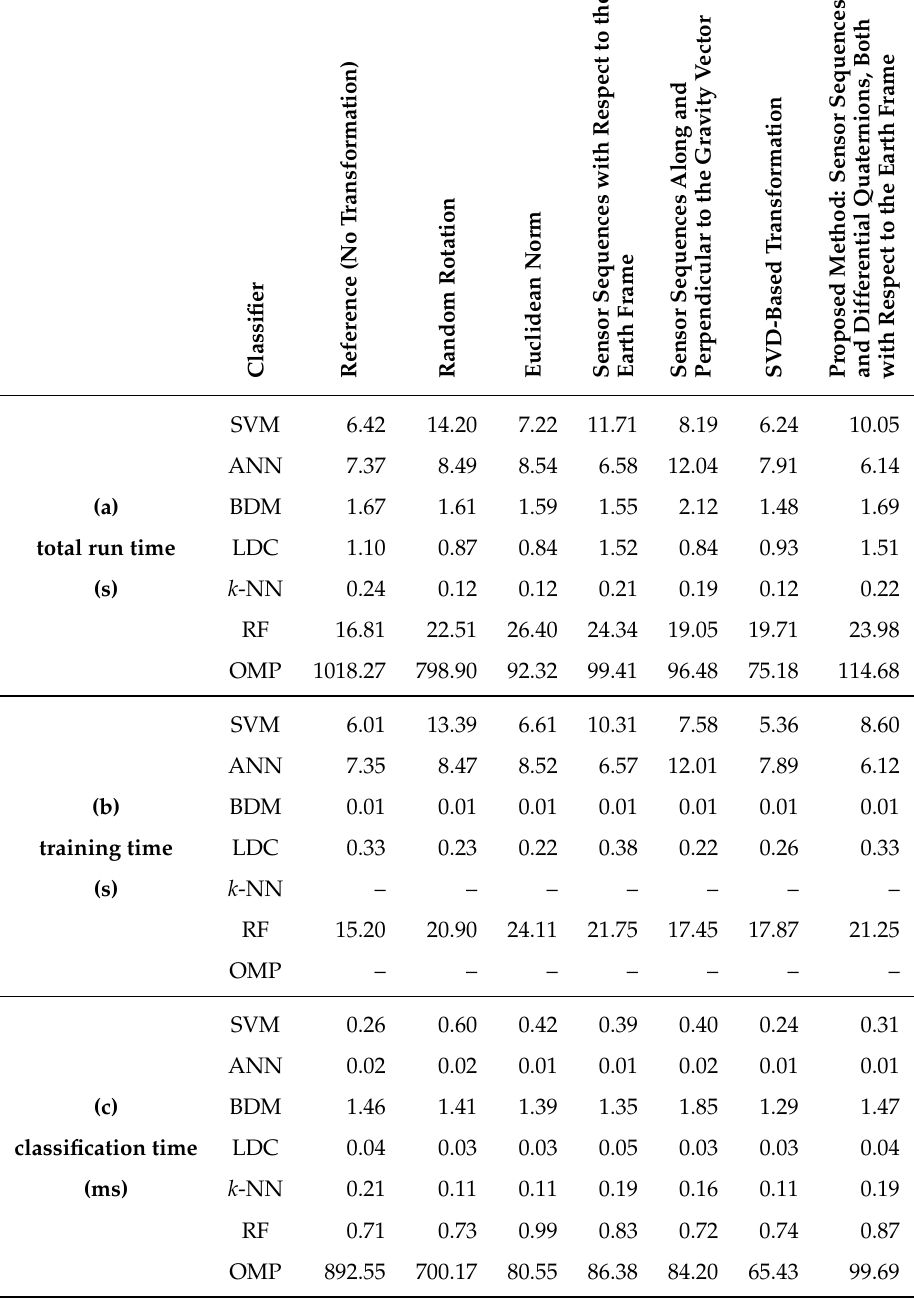
Table 3. ( a ) Total run time (including training and classification of all test feature vectors)